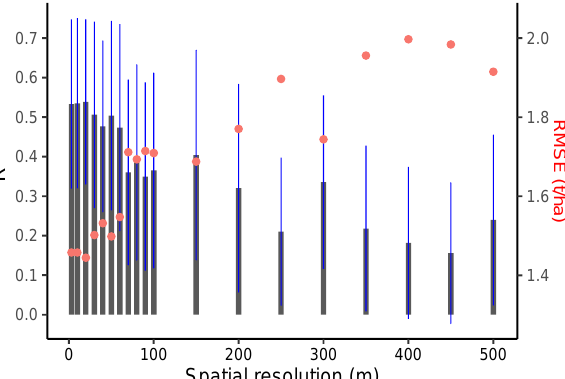
Figure 6. Performance of linear regressions between in situ yield and PlanetScope EVI resampled to different spatial resolutions (3, 10 m, 20 m, … , 100 m, 200 m, … , 500 m). Gray bars indicate R 2 , and the blue lines indicate R 2 standard deviation. The red dots show RMSE (right-hand y -axis).